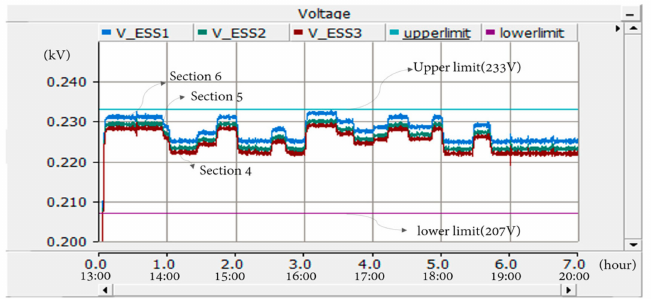
Figure 19. Analysis of the customer voltage characteristic by ESS and SVR operation (upper